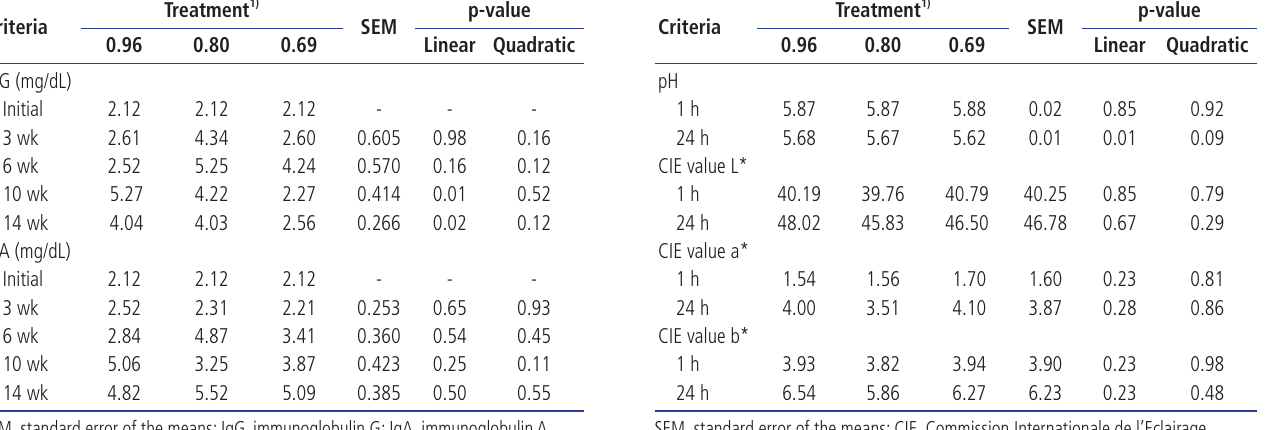
Table 5. Effect of different space allowance on pork pH and lightness